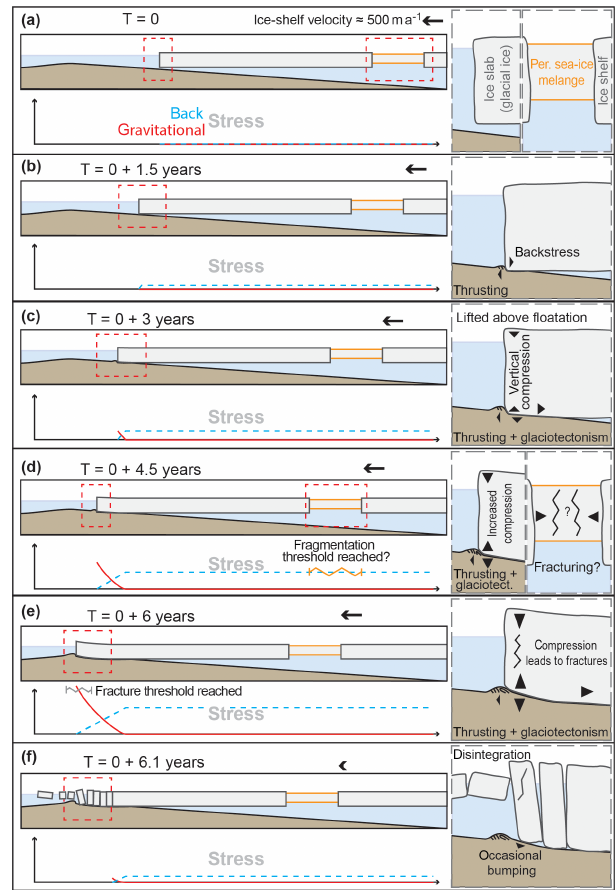
Figure 10. Sketch of the proposed iceberg ramp (Class H) forma- tion process, including a conceptual graph of stresses active dur- ing formation, with time estimates based on modern ice shelf flow velocity of about 500ma − 1 . (a) Setting before the contact of the ice slab with the seafloor. (b) Initial contact of the ice slab with the seafloor leads to seaward directed thrusting of sediments at the front of the slab and build-up of back stress within the ice slab further up- stream of the point of contact. (c) The front of the ice slab is “jacked up” causing gravitational stresses and vertical compression within the ice slab; continued thrusting of the sediments combined with their compression leads to glaciotectonism, and back stress within the slab increases further. (d) Continued uplift of the slab front in- creases stresses, with the back stress probably exceeding a thresh- old that causes the fragmentation of the perennial sea ice melange. (e) Gravitational stress reaches a level that causes fracturing of the ice slab front. (f) The ice slab disintegrates into smaller icebergs, which capsize and occasionally “bump” into the top of the newly formed ramps when they drift